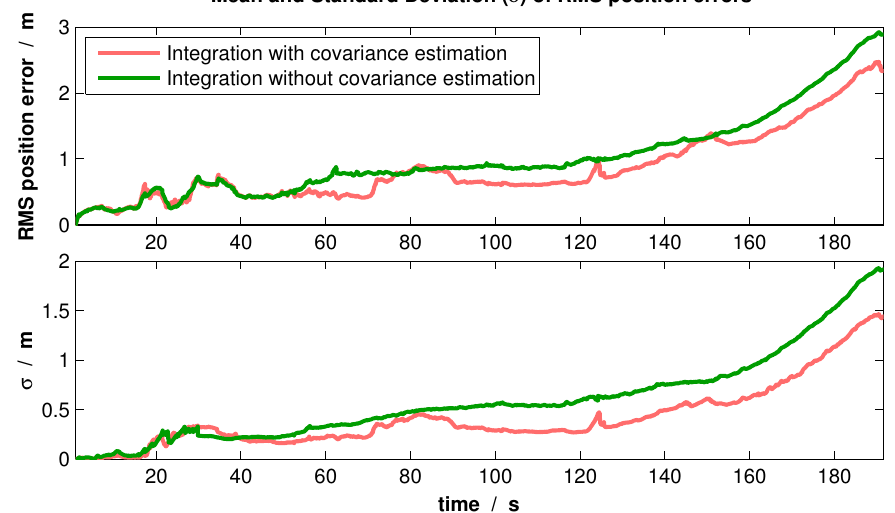
Figure 14. Mean and standard deviation of the RMS position error by reprocessing a real flight multiple